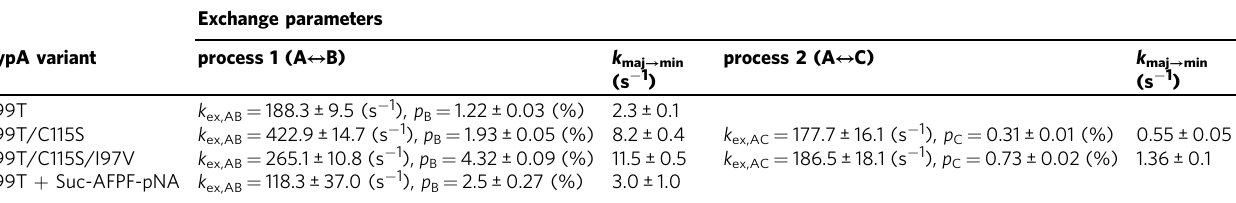
Table 2 Exchange parameters extracted from 15 N-CEST experiments for CypA variants measured at 10